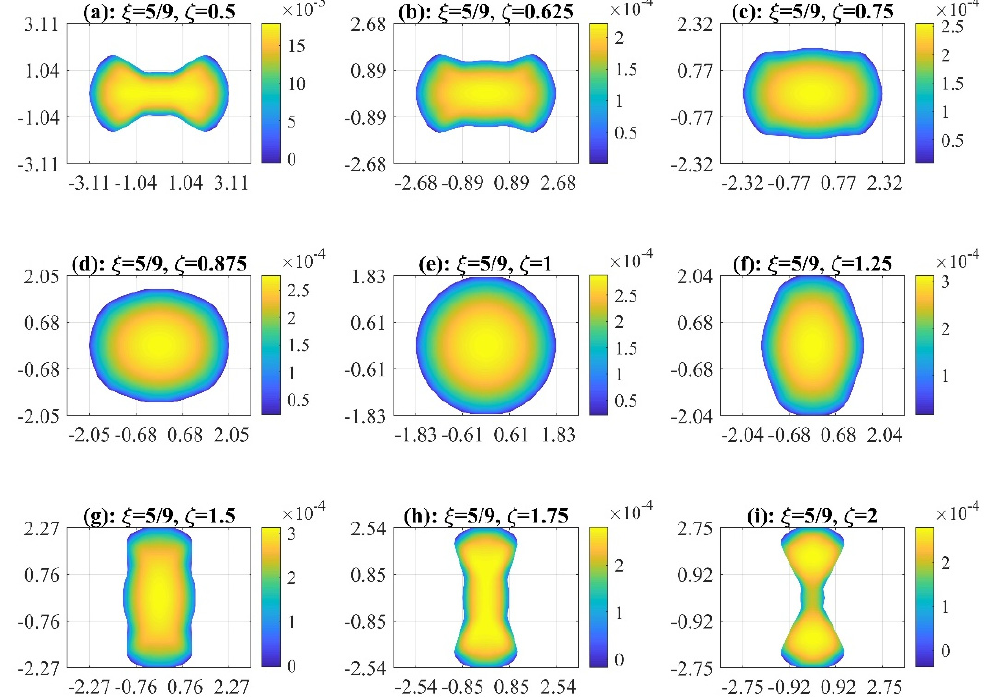
Figure 12. Distributions of fracture opening of Group 3 numerical experiments ( ξ = 5/9) with 9 different fracture toughness contrasts at the moment = 20 s .